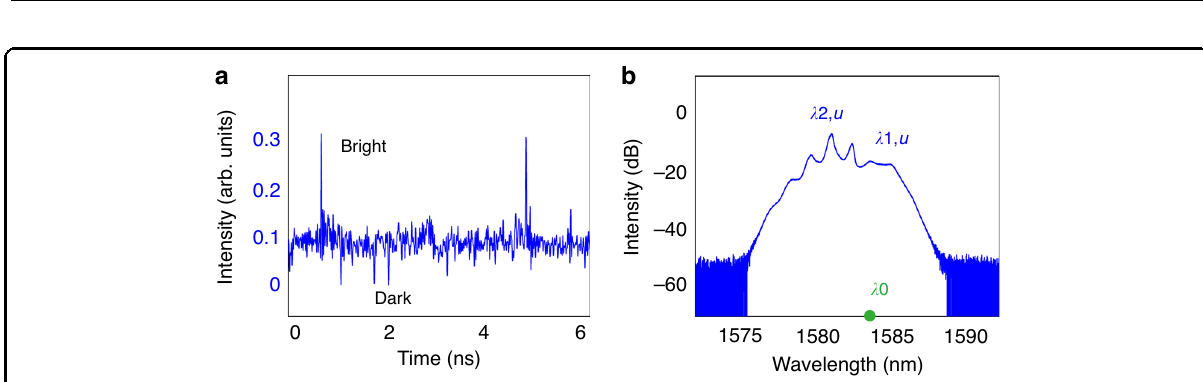
Fig. 3 Scalar DSs and BSs simultaneously formed along the same polarization. a Coexistence of scalar BSs and DSs. b Optical spectrum of Fig. 3a. λ 0 : central wavelength of the ZGVD point, λ 1,u : central wavelength of the BSs, λ 2, u : central wavelength of the DSs